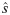
Experimental strategies.(A) An illustration of a feedforward network with linear readout. The decoder linearly combines the activity r of neurons in two populations x and y with weights w, to produce an estimate s^ of the stimulus. Activity of individual neurons rk is correlated with s^ and is quantified by either the choice probability CPk, or the closely related choice correlation Ck. In an optimal system, the weights w generate choice correlations that satisfy Eq (4). (B) In inactivation experiments, the neurons from each population are inactivated and the resulting changes in behavioural threshold are recorded.